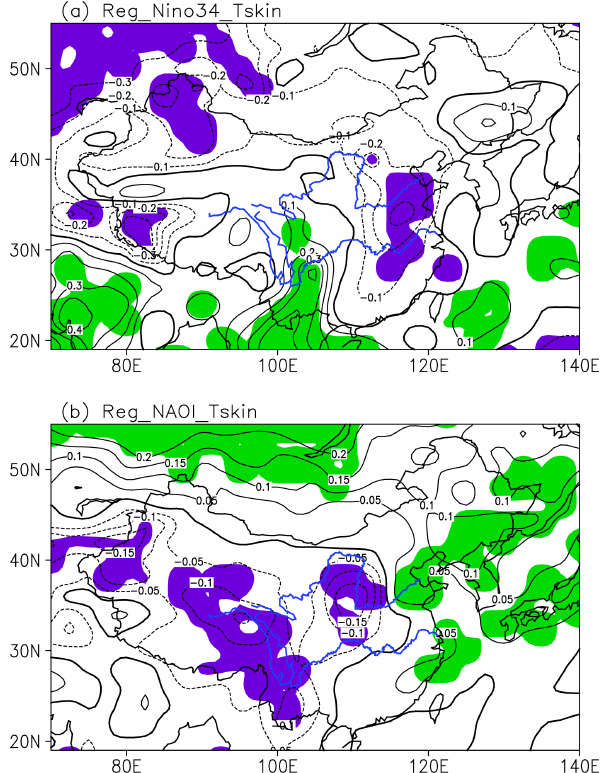
Figure 8. Regressions of the planetary boundary layer height (PBLH) onto the (a) 3 month leading Niño 3.4 index and (b) si- multaneous NAOI. Color shading indicates significance at the 0.05 level.